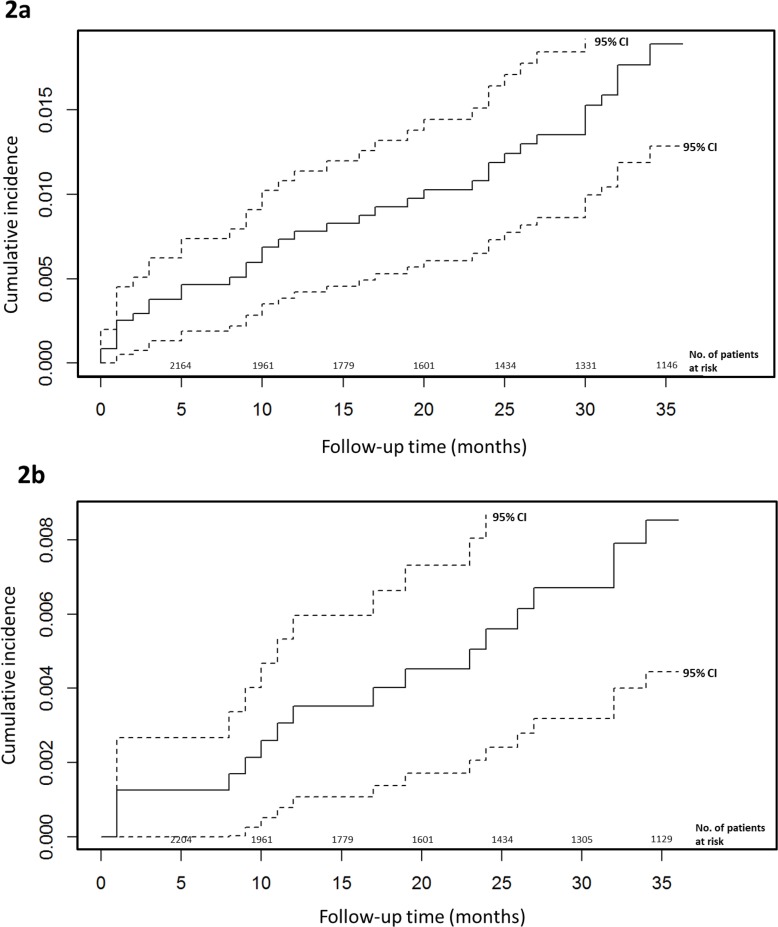
Cumulative incidence with 95% confidence interval estimate of venous thromboembolism (Fig 2A) and acute pulmonary embolism (Fig 2B) during 36 months after hospitalization for investigation of syncope.